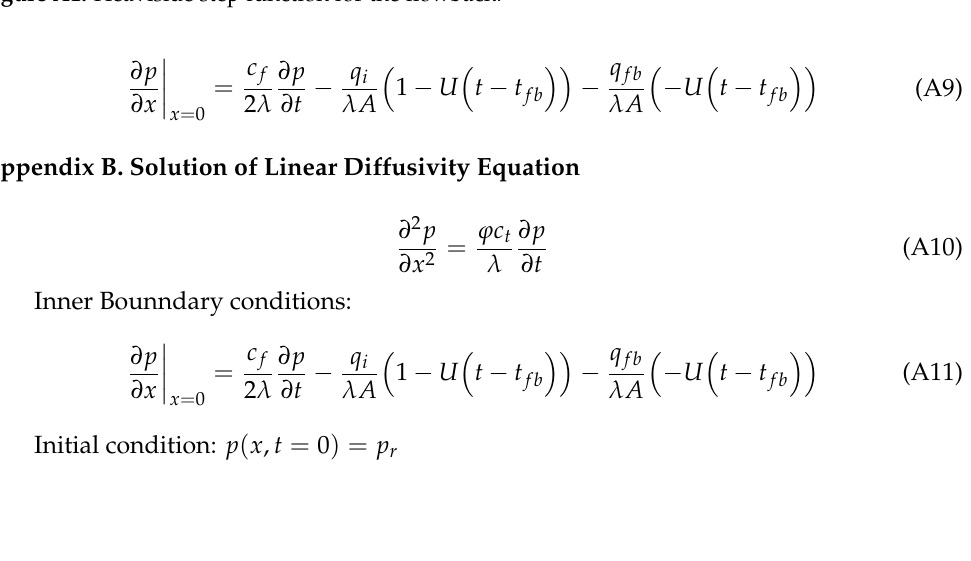
Figure A1. Heaviside step function for the